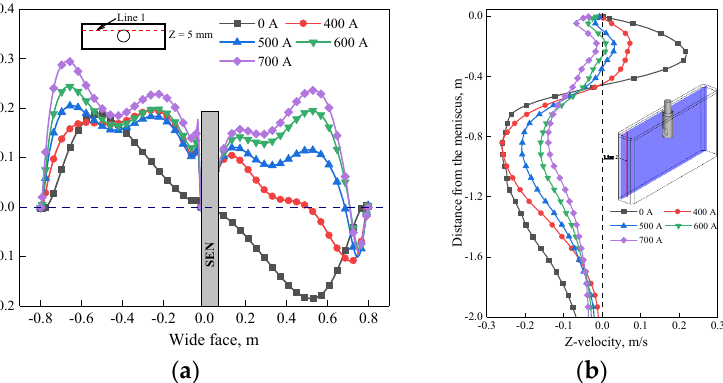
Figure 6. Variation of velocity under different EMS currents: ( a ) X-velocity at line 1, ( b ) Z-velocity at line 2.